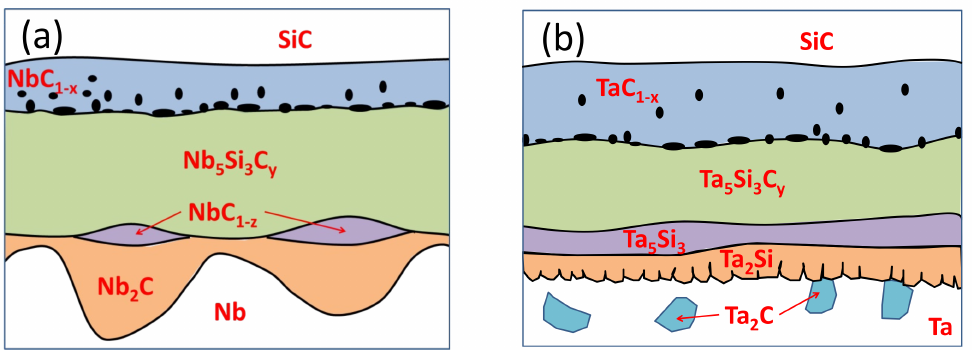
Figure 11. Schematic illustration of the reaction zone in the Nb/SiC ( a ) and Ta/SiC ( b ) systems at 1200 ◦ C.